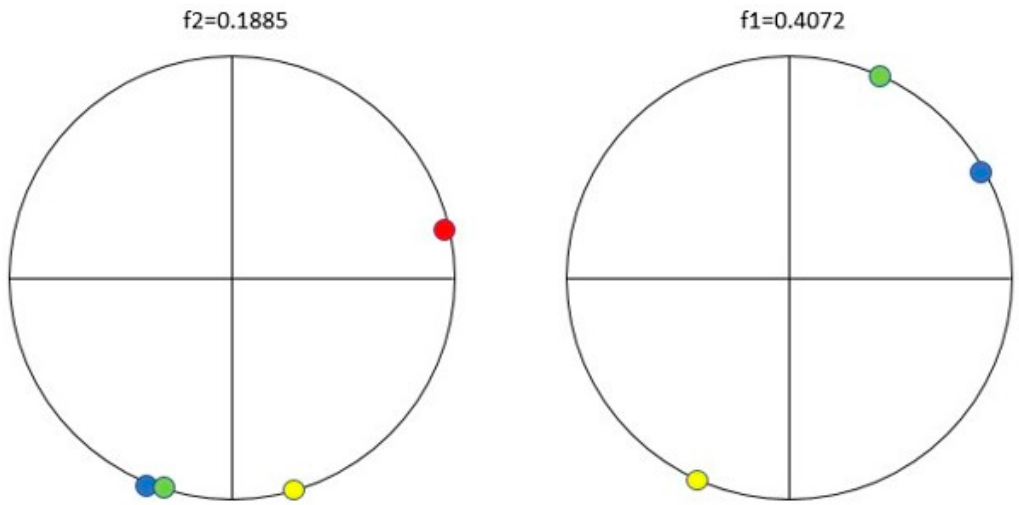
Figure 5. Phases for parathyroid hormone protein, fragments and receptor for frequencies f2 and f1. The colour of each phase corresponds to the colour of proteins in Table 1.